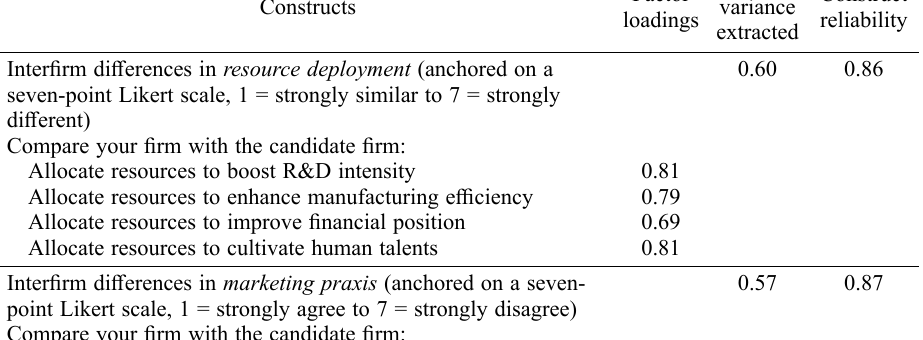
Table 3. Survey items for cognitive interfirm differences Constructs